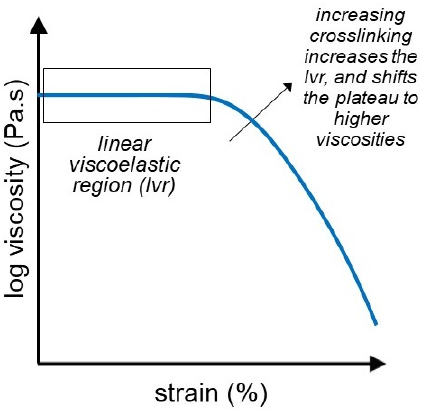
Figure 4. Strain sweep or amplitude sweep in hydrogels shows the linear viscoelastic region (LVR) as well as the threshold strain required above which shear thinning behavior is observed.